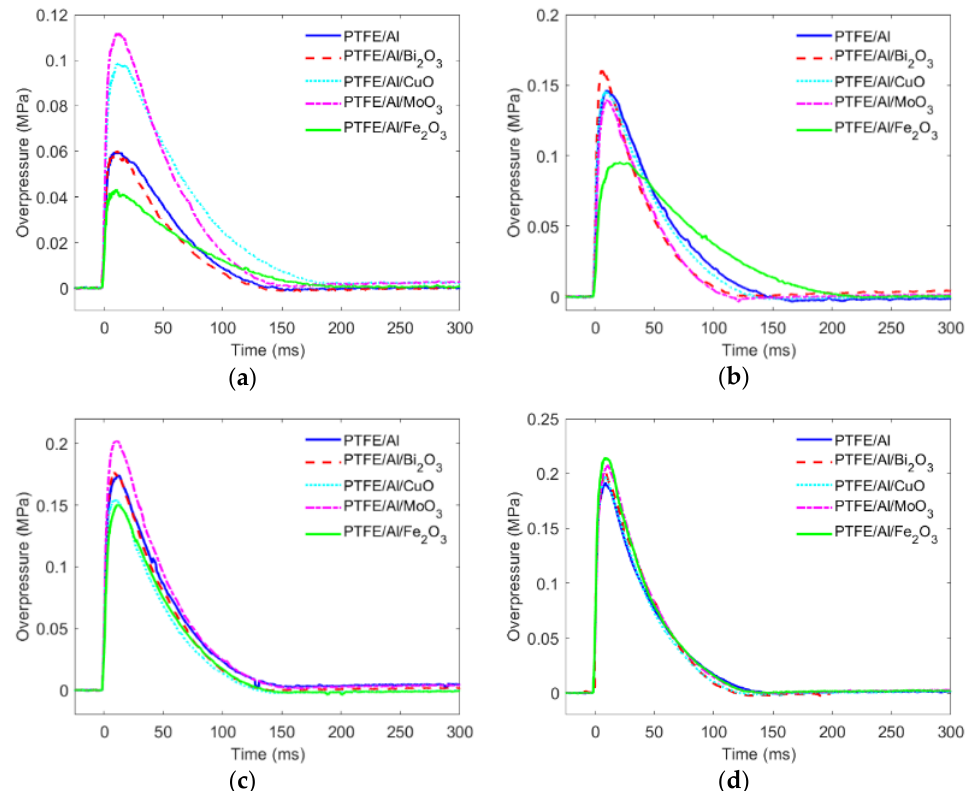
Figure 6. The quasi-static overpressure varying time: ( a ) nominal velocity 735 m/s; ( b ) nominal velocity 920 m/s; ( c ) nominal velocity 1127 m/s; ( d ) nominal velocity 1290 m/s. Table 4. The quasi-static overpressure characteristic.